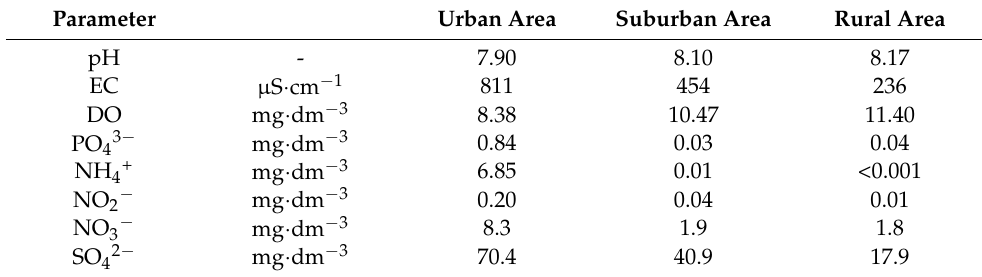
Table 1. Average concentrations of physical and chemical indices for surface water in the entire studied